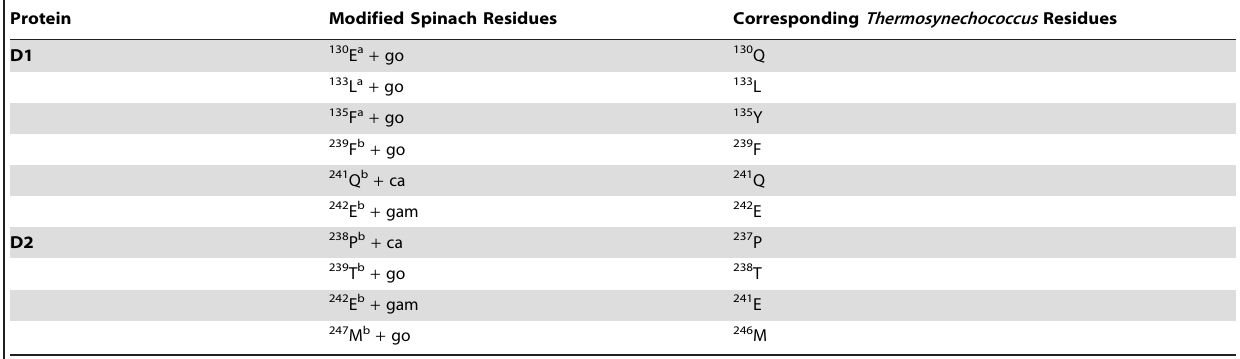
Individual residues are listed along with the modifications observed. For a complete list of oxidative modification types, the amino acids targeted, and mass modifications searched for in this study, as well as structures arising from these oxidative modifications, see [50,51]. Key: ca, carbonyl addition ( + 14 Da); gam, Glu/Asp modification (decarboxylation and oxidation, 2 30 Da); go, general oxidation ( + 16 Da). Oxidative modification of these residues was originally reported in Frankel et al. [20]. a Buried residues not adjacent to apparent cavities/channels. b Surface-exposed residues.